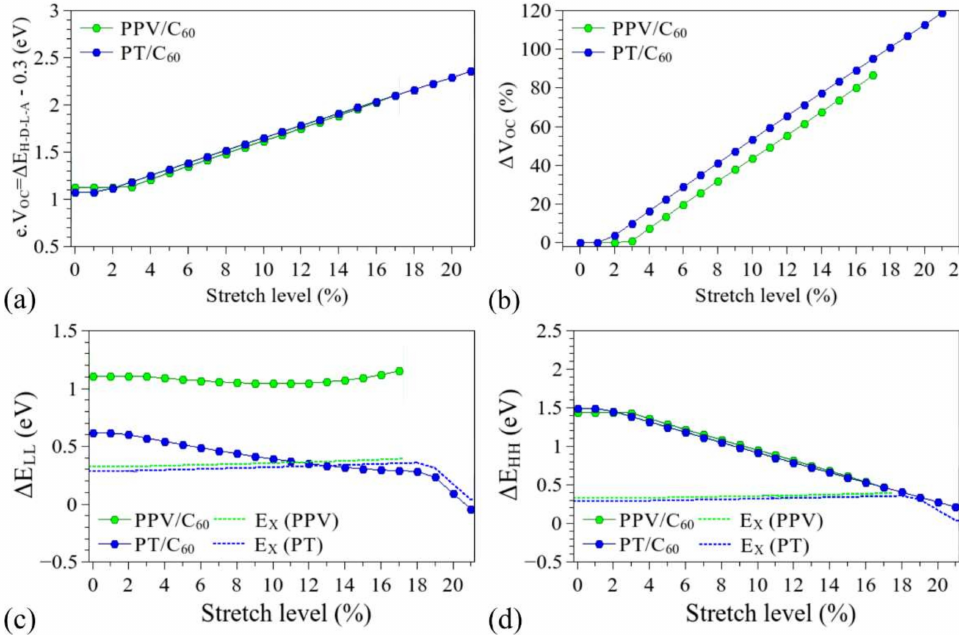
Figure 14. Evolution of the parameters ( a ) V OC , ( b ) ∆ V OC , ( c ) ∆ E LL , and ( d ) ∆ E HH during the stretching processes for C 60 -based devices.